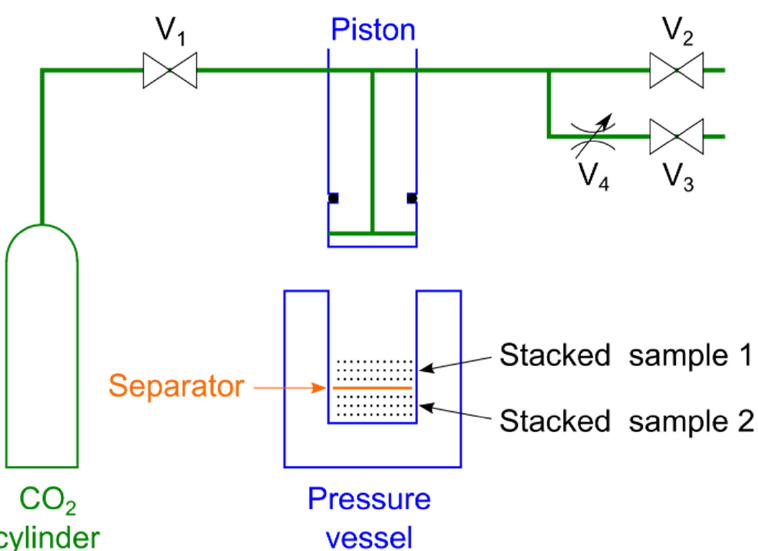
Figure 1. Experimental equipment diagram. The pressure vessel and the piston are sealed with an O-ring on the side of the piston. The samples are put with a separator sandwiched between layers so that the layers do not stick to each other. V 1 : introduction valve; V 2 : high-speed exhaust valve; V 3 : low-speed exhaust valve; V 4 : metering valve.